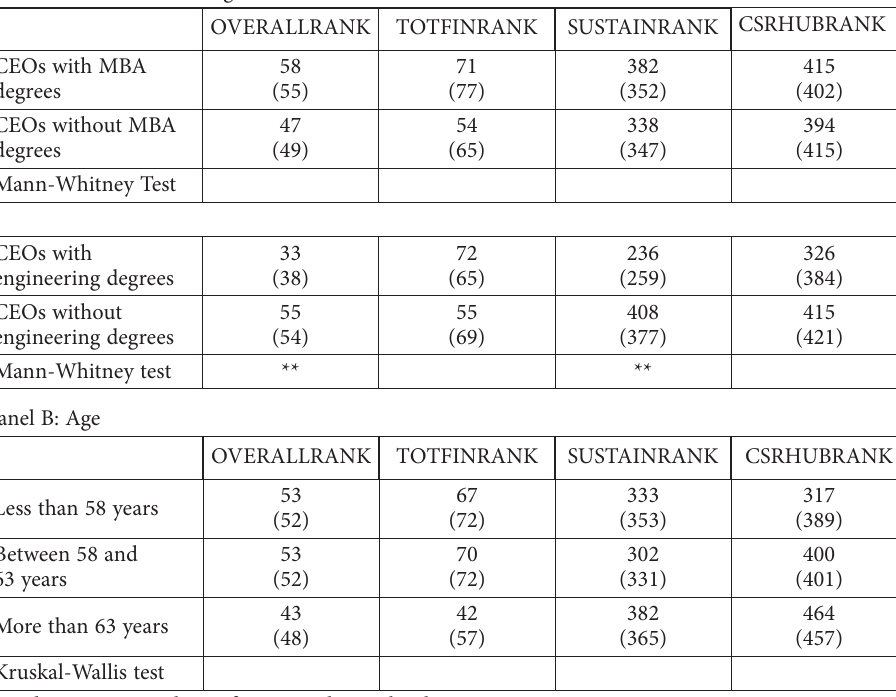
Table 6. Median (mean) positions in rankings by educational background and age Panel A. Educational